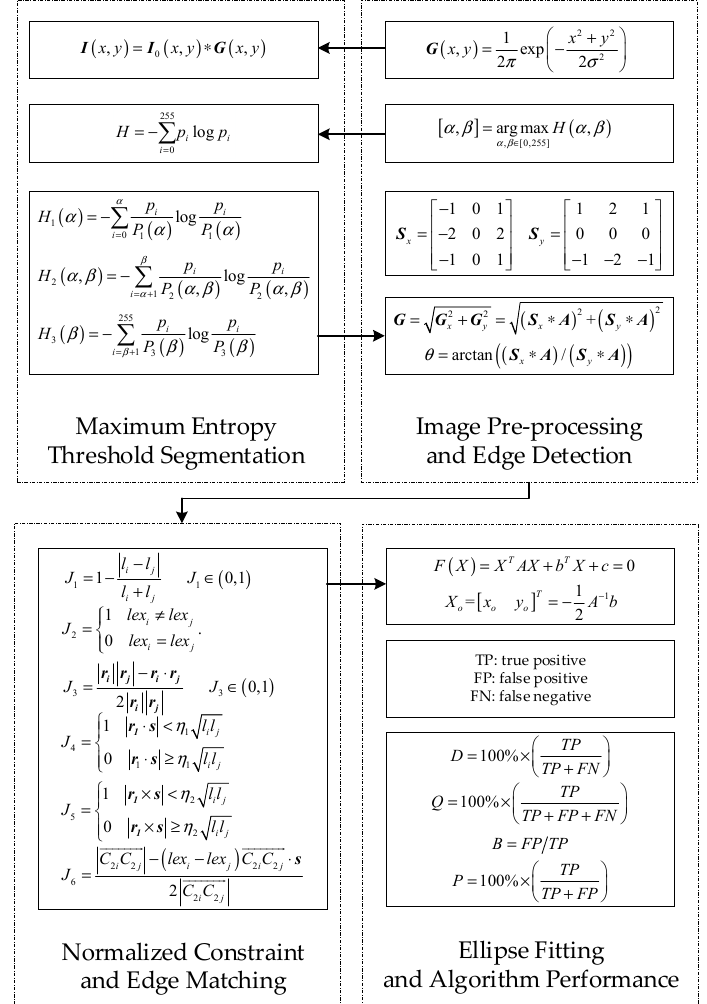
Figure 1. Technology roadmap of METS-CDA.